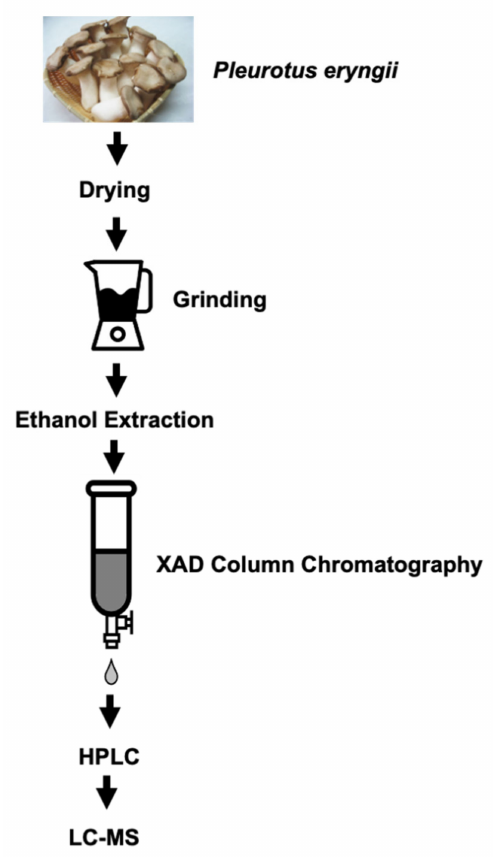
Figure 1. Procedure for isolating functional molecules from P. eryngii